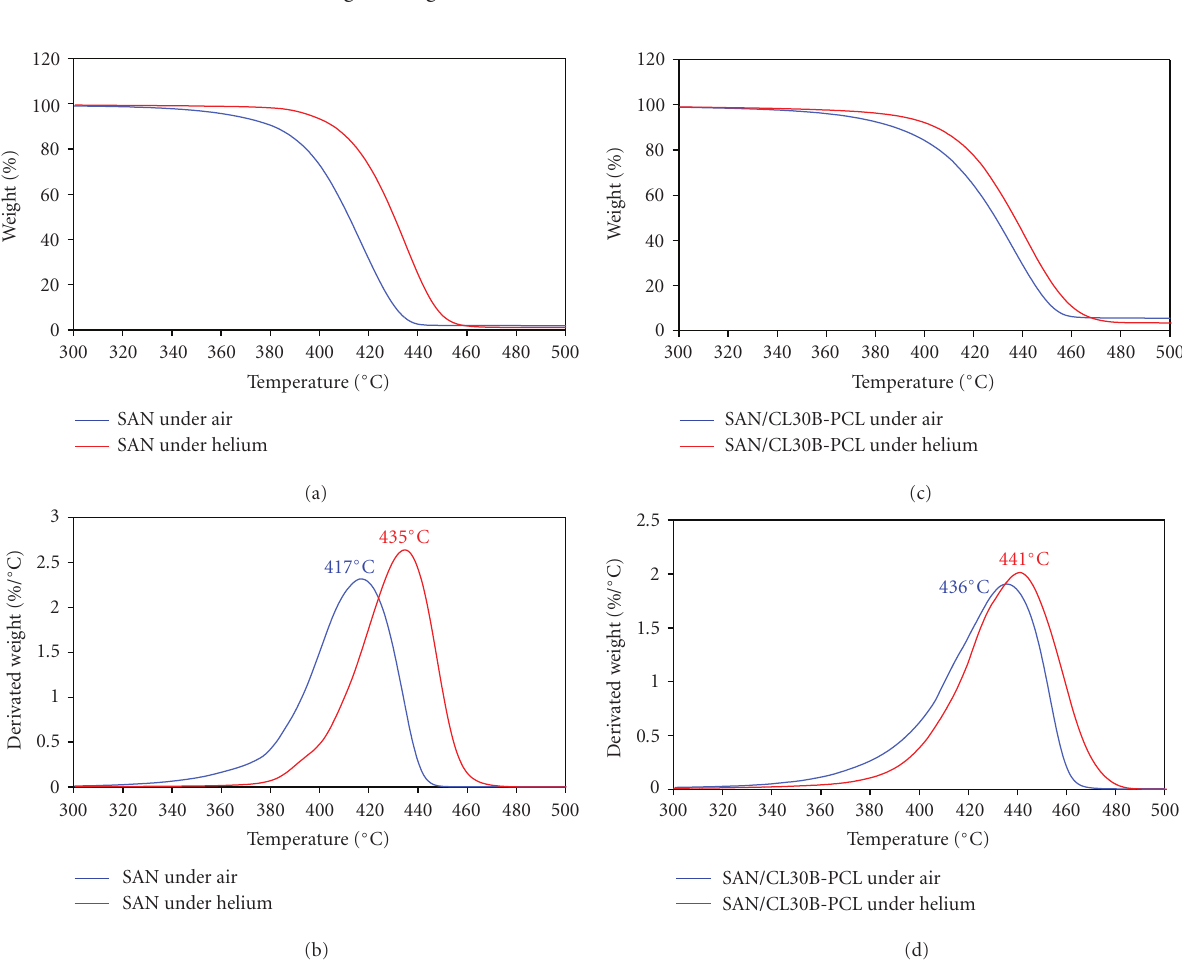
Figure 4: Thermogravimetric analysis curves of SAN and SAN/CL30B-PCL with 3wt% of inorganics in air and in helium, at 20 ◦